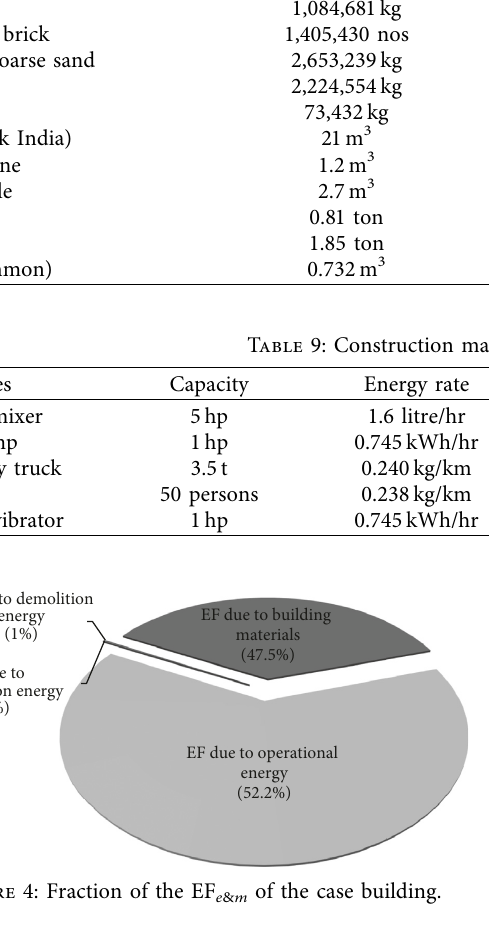
e & m of the case building.